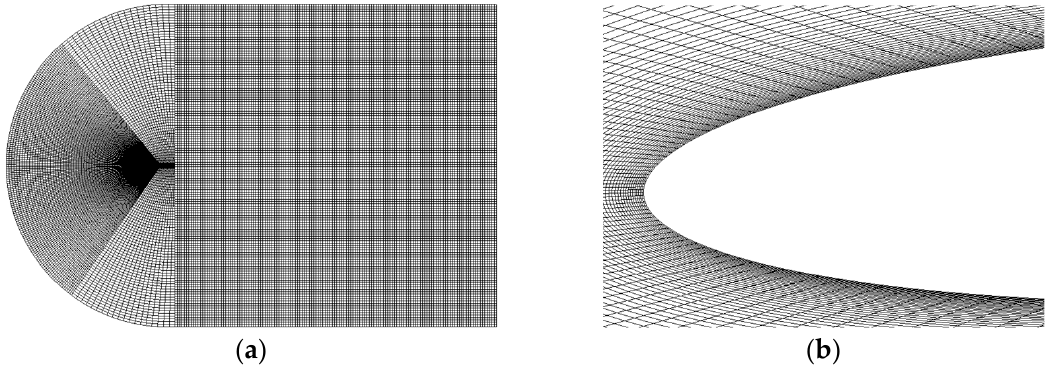
Figure 9. Mesh distribution. ( a ) Mesh domain; ( b ) mesh on the leading edge of airfoil. Figure 10 shows the velocity vector of the airfoil for a Reynolds number of 60,000. As shown in Figure 10a, two high-speed regions appeared at the leading edge of the upper surface for 4 ◦ , where the Bernoulli equation showed that the low pressure on the upper surface was relatively small. The boundary layer flow between the leading edge and the raised curve of the upper surface of the airfoil tended to be laminar, but the boundary layer flow between the raised curve and the trailing edge already showed a laminar separation. As can be seen in Figure 10b, the laminar separation increased at the trailing edge of the upper surface and decreased in the high-speed region at 8 ◦ . Vortices appeared on the upper surface of the rotor blade. In addition, as shown in Figure 10c, there were still